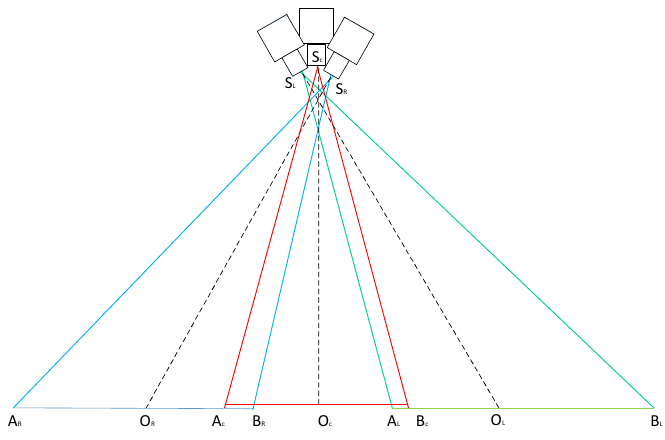
Figure 1. Imaging principle of AWSHRHIS.